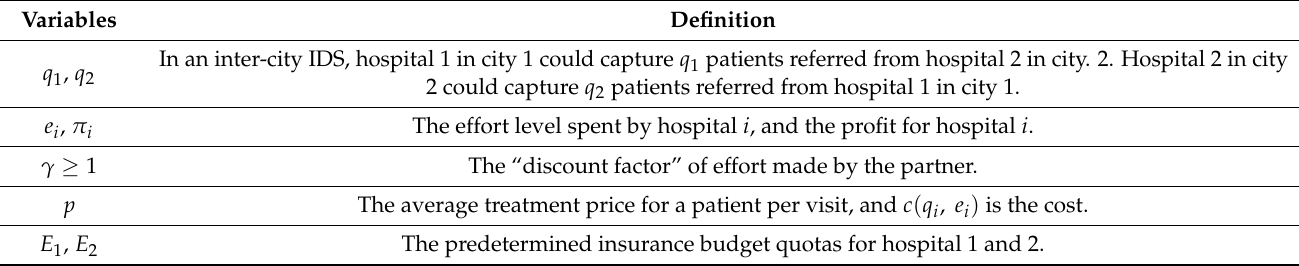
Table 2. Key variables in the conceptual model at the inter-hospital